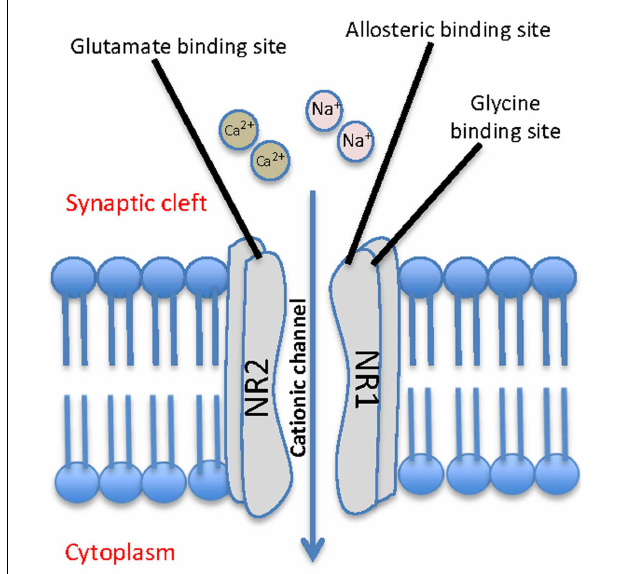
FIGURE 1 | Schematic representation of a typical NMDA receptor .The NMDA contains four subunits, two glycine binding NR1 subunits and two glutamate binding NR2 subunits, and allows for cationic influx from the synaptic cleft into the